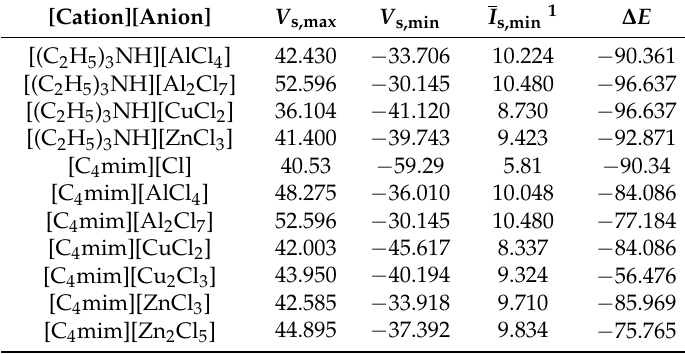
Table 1. Cation-anion interaction energies and surface parameters of the Room-temperature ionic liquids (ILs)